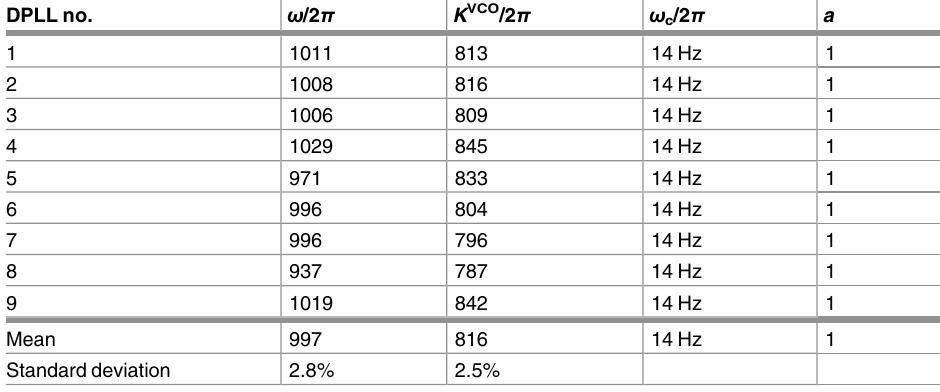
Table 1. Specification of the DPLLs in the experimental setup. DPLL